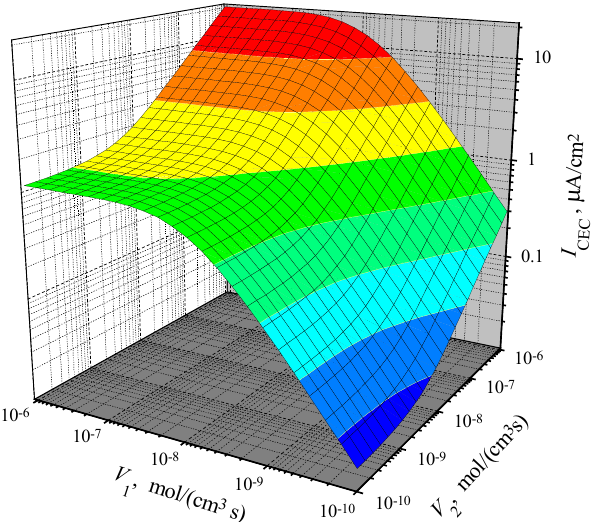
and V of the biosensor 1 2